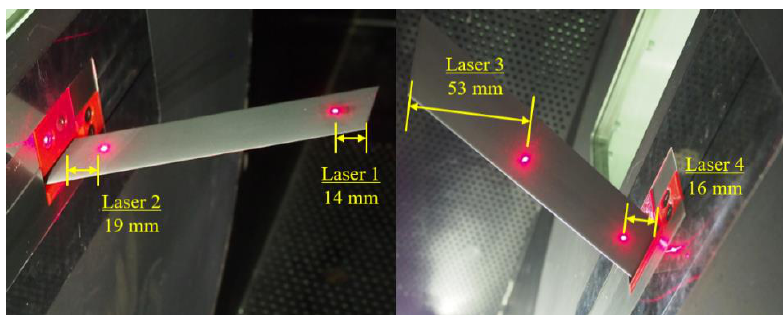
Figure 13. Measurement locations of the laser displacement sensors.